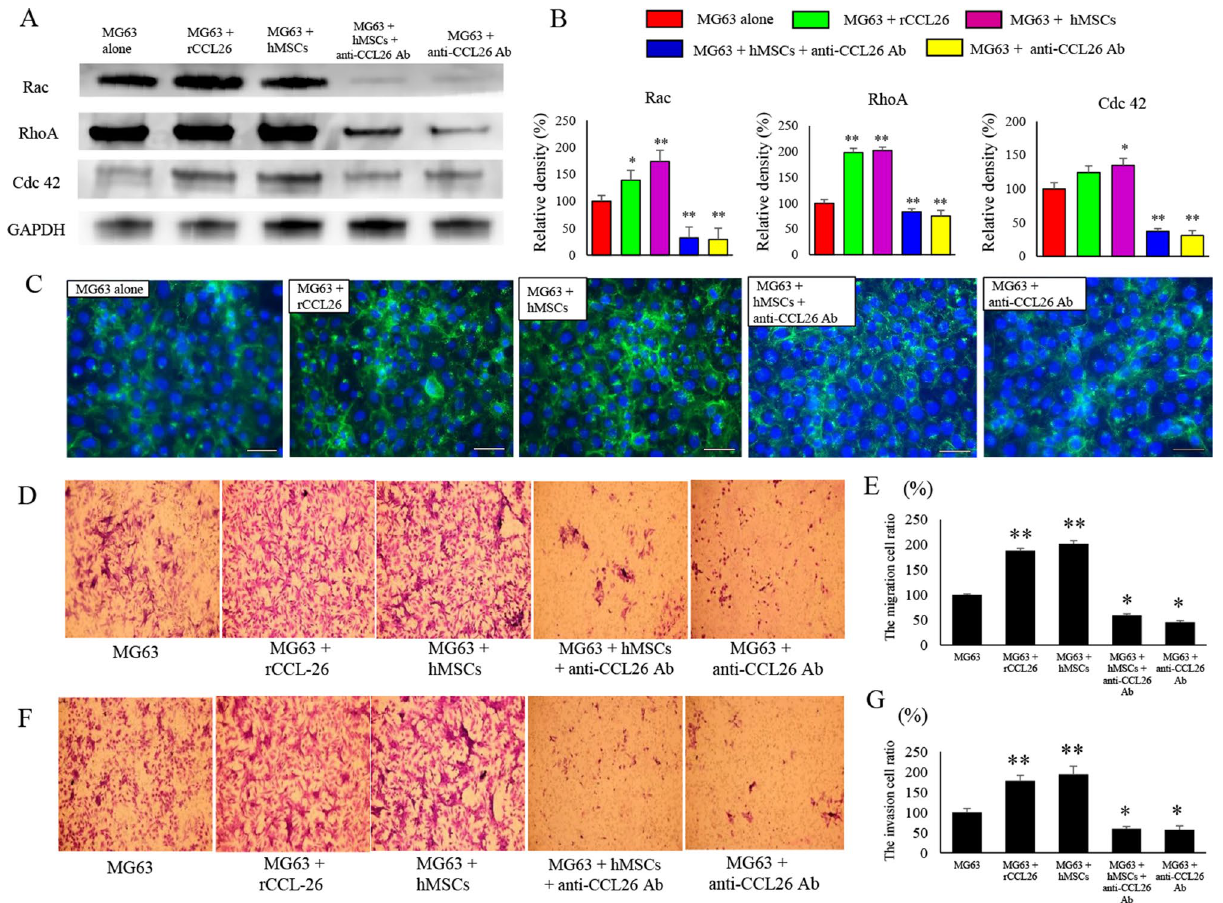
Figure 4. Effects of co-culture condition and administration of rCCL26 or anti-CCL26 Ab on motility of MG63. ( A ) Changes in protein expression of factors related to cell motility. ( B ) The quantification of western blot analysis. Data represents represent the mean ± SD of three independent experiments. ( C ) The influence of co-culture and rCCL26 or anti-CCL26 Ab on actin fiber morphology was evaluated using immunofluorescent imaging. Original magnification, × 400; Scale bars: 50 μm. ( D ) The cell migration of MG63 was assessed in each group at 24 h after the challenge with or without rCCL26 and neutralizing anti-CCL26 Ab. ( E ) The amount of MG63 cells that crossed the membrane was measured. A significant decrease in motility was found in the group given anti-CCL26 Ab. ( F ) The cell invasion in MG63 was assessed in each group after 24 h. ( G ) The amount of the cells of which the membrane with Matrigel was crossed by MG63 was measured. Decreased migration ability was found in the group administered anti-CCL26 Ab. p < 0.05 was considered to indicate significance: (*) p < 0.05, (**) p <